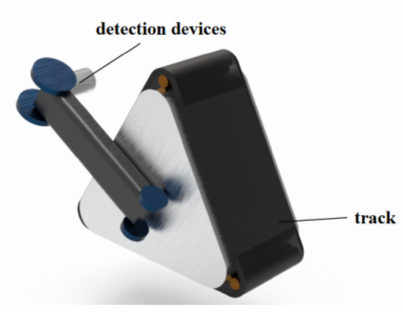
Figure 5. Self-reconfigurable